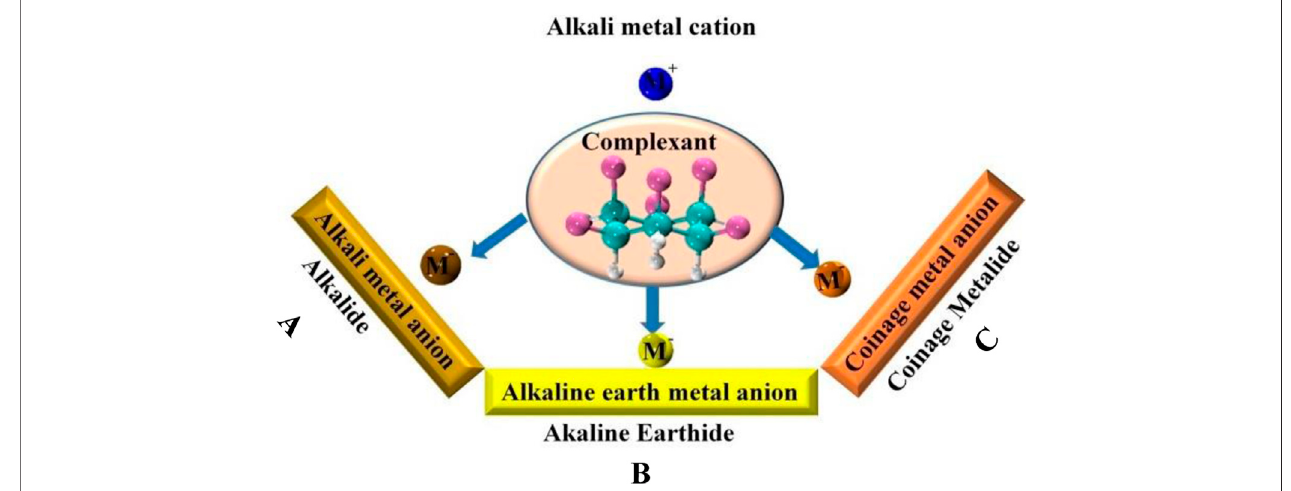
FIGURE 4 | A general representation of alkalide, alkaline earthide, and coinage metalide complexes.